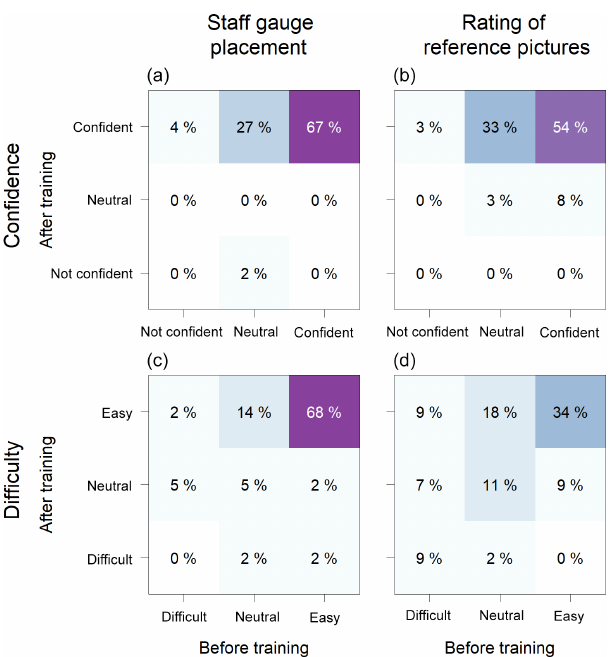
Figure 11. Percentage of participants who chose a certain con- fidence level (a, b) and their assessment of the difficulty of the task (c, d) for the staff gauge placement (a, c) and rating of refer- ence pictures (b, d) before the training ( x axis) and after the training ( y axis). Darker colours indicate that a higher percentage of partic- ipants chose these